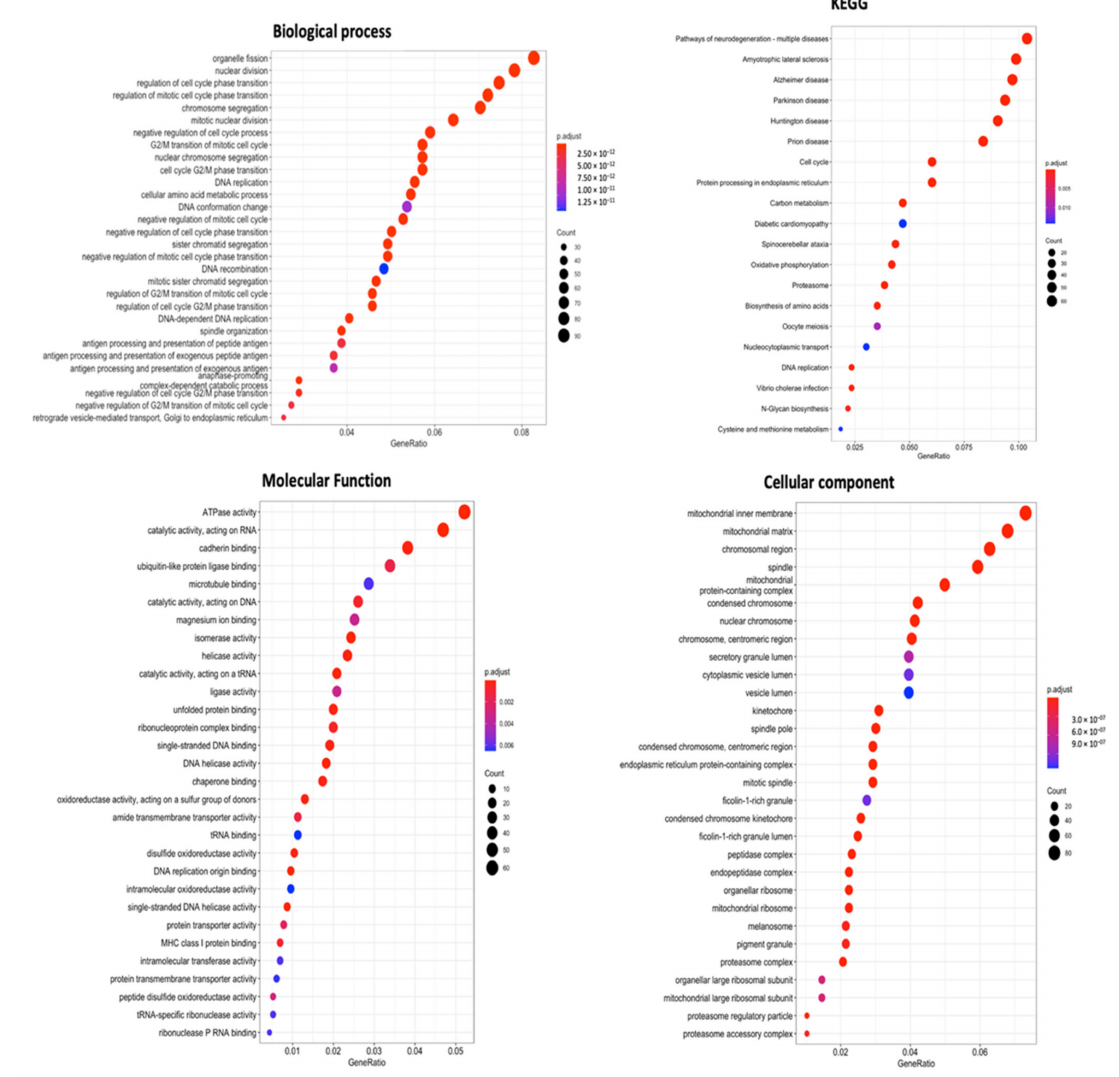
Figure 10. Gene ontology (GO) keywords with gene p values (cellular components, biological processes, molecular functions, and KEGG ontology). Number of genes counted in each function is represented by the size of the circles, and the colors of the bubbles correlate with p